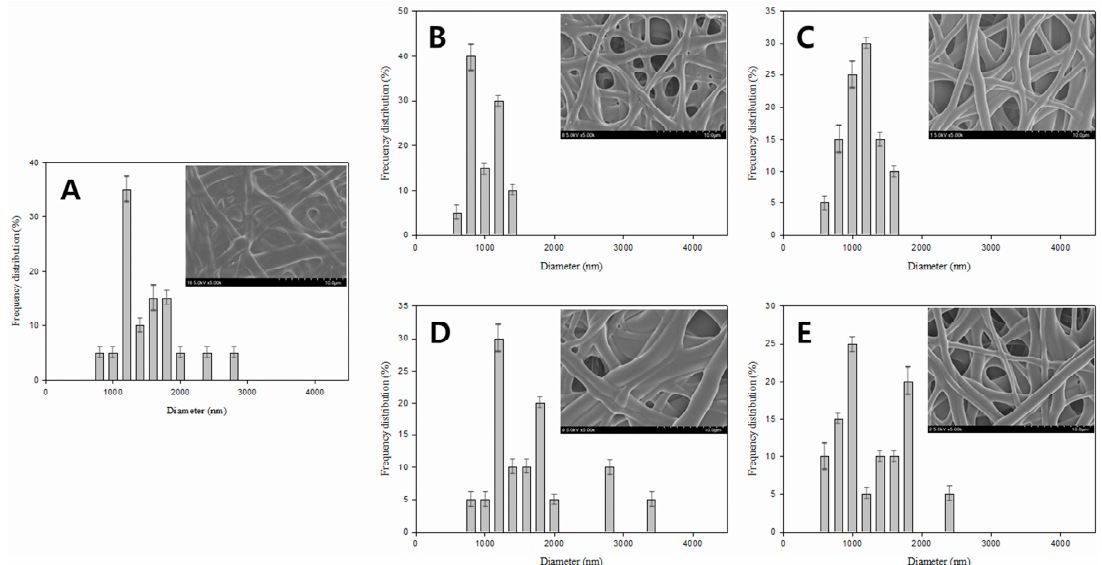
Figure 7. Fiber diameter histogram plots and FE-SEM images for saponified PVA nanofiber mats obtained using a saponification solution prepared with different respective quantities of NaOH, Na 2 SO 4 , and MeOH per 100 g of H 2 O: ( A ) 5, 5, and 5 g; ( B ) 7.5, 5, and 5 g; ( C ) 10, 5, and 5 g; ( D ) 5, 7.5, and 5 g; and ( E ) 5, 10, and 5 g. The saponification time and temperature were kept constant at 24 h and 25 °C, respectively.